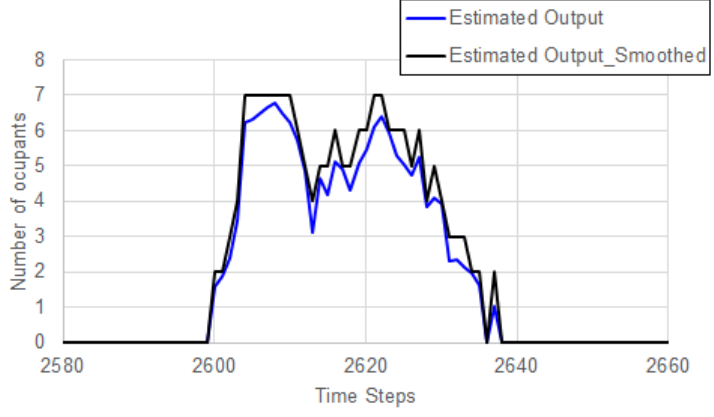
Figure 8. One working day occupancy smoothing results.